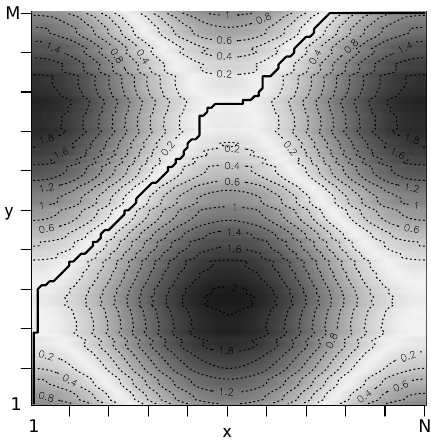
Figure 1. Local costs of two time series x and y and the optimal warping path p ∗ (solid line). Regions of low cost (high cost) are presented by light colors (dark